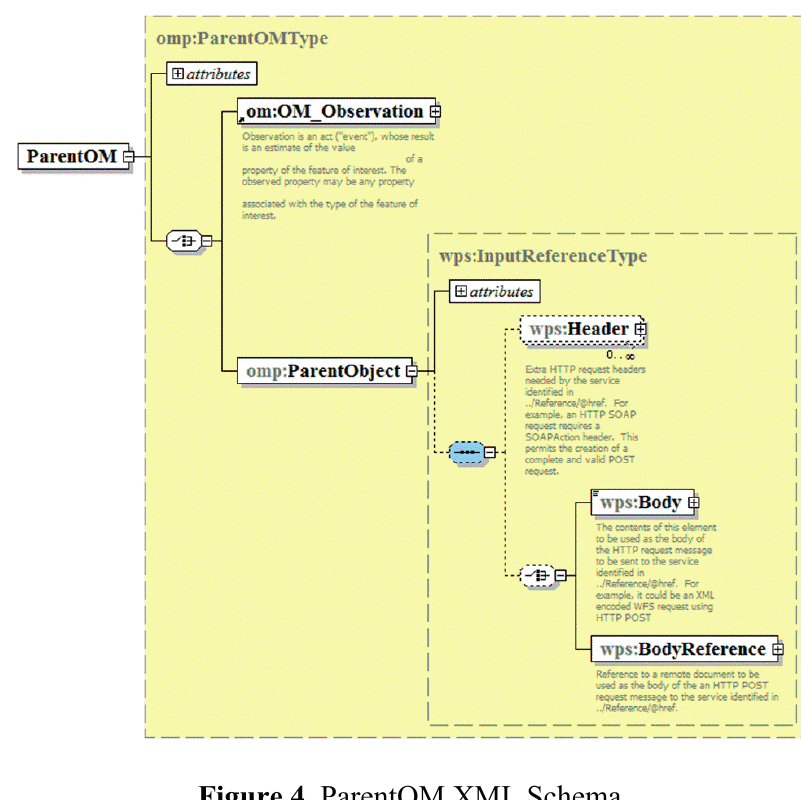
Figure 4. ParentOM XML Schema.